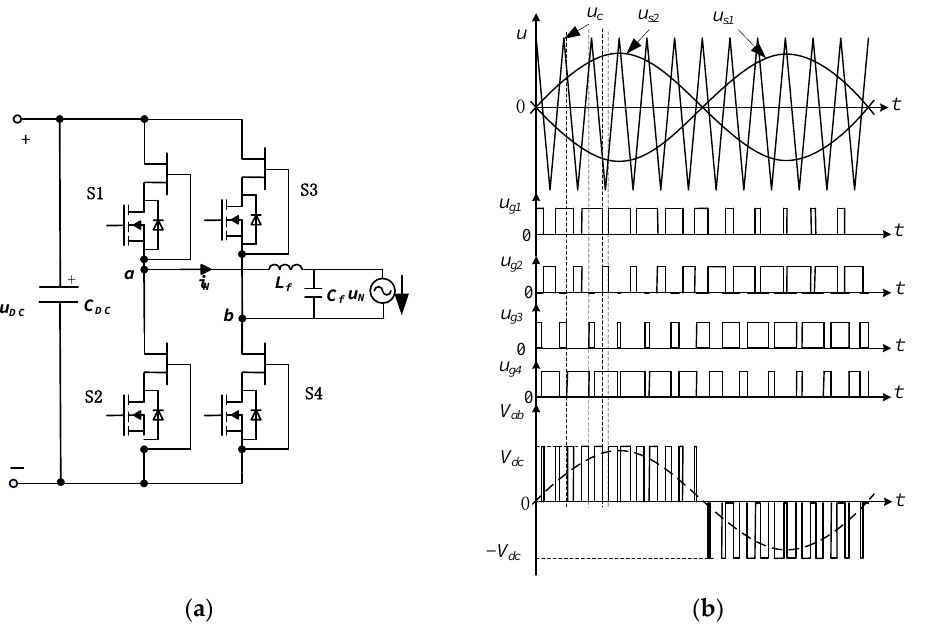
Figure 2. The topology of the cascode GaN HEMT-based inverter and its control strategy. ( a ) The topology of the cascode GaN HEMT-based inverter; ( b ) The control strategy of the cascode GaN HEMT-based inverter.